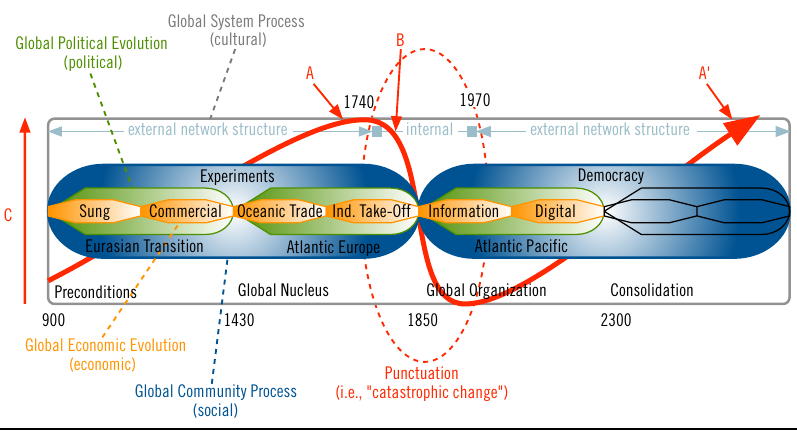
* Figure 1 graphically summarizes our model of the modern era globalization process that is the basis of this analysis. In this view, the global system process is driven by the nested processes of economic development (most-inner octagon, labeled Sung, Commercial, Oceanic trade, Industrial take-off, Information, and Digital); political development (bullet-shaped boxes, labeled Eurasian transition, Atlantic-Europe, and Atlantic Pacific); and social development (rounded boxes labeled Experiments and Democracy). Together, they constitute the global system development (represented by the thin-grey box framing all other